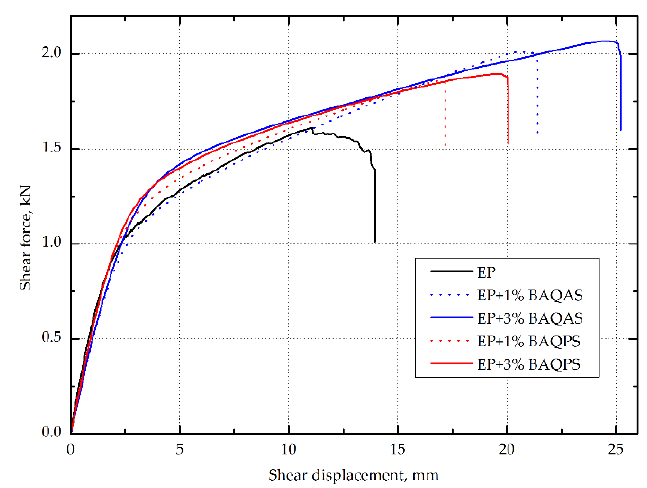
Figure 7. The shear stress vs. shear strain relationship in the range of 0–0.05 of Kevlar-reinforced laminates with EP and EP containing modified bentonite matrices.